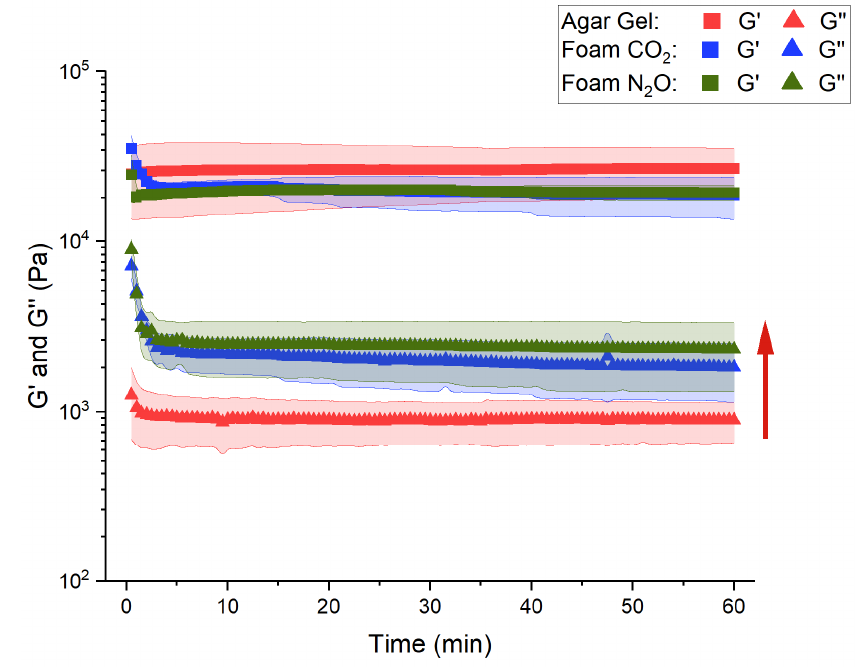
Figure 7. Viscoelastic modulus analyzed on a time sweep test.